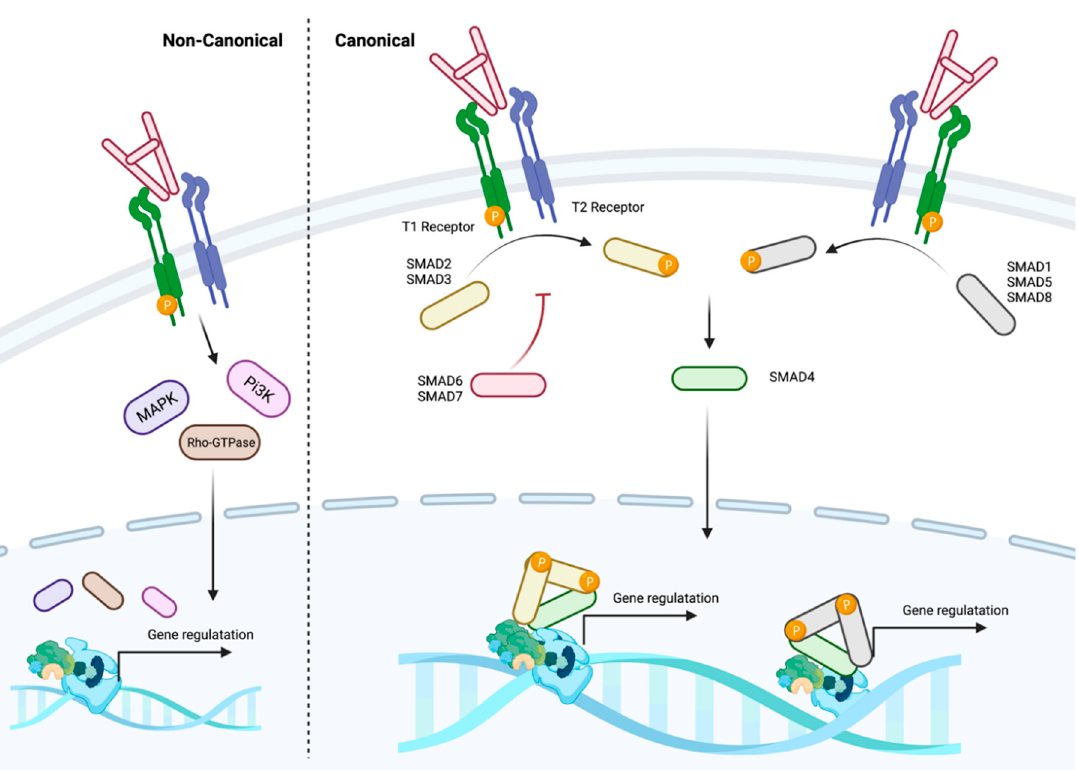
Figure 3. Overview of core TGFB signalling. In the canonical pathway, active TGFB binds to pre- formed dimers of type-1 (TGFBR1) and type-2 (TGFBR2) receptors to form a heterotetrametric active receptor complex. The constitutively active type-2 receptor activates type-1 receptor kinase activity, allowing recruitment and phosphorylation of R-SMADs and the formation of complexes with SMAD4. These SMAD4 complexes translocate to the nucleus and regulate gene expression in com- bination with transcription factors, histone-modifying enzymes, and chromatin remodelling com- plexes. TGFB receptor activation can also trigger non-SMAD-mediated signalling (non-canonical) including activation of MAPK, PI3K, or Rho GTPases. Figure generated using Biorender.com (ac- cessed 28 February 2022).